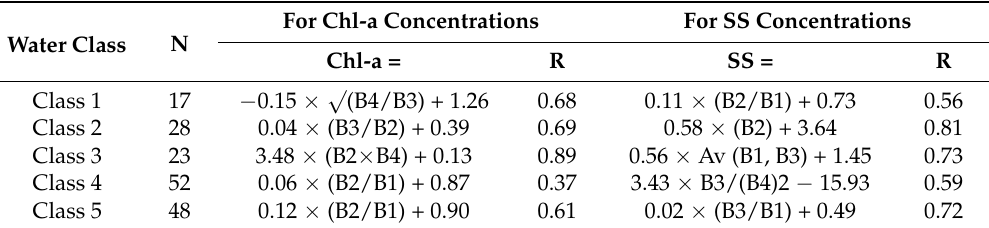
Table 3. Class-specific empirical predictive equations and correlation coefficients for Chl-a and SS concentrations.